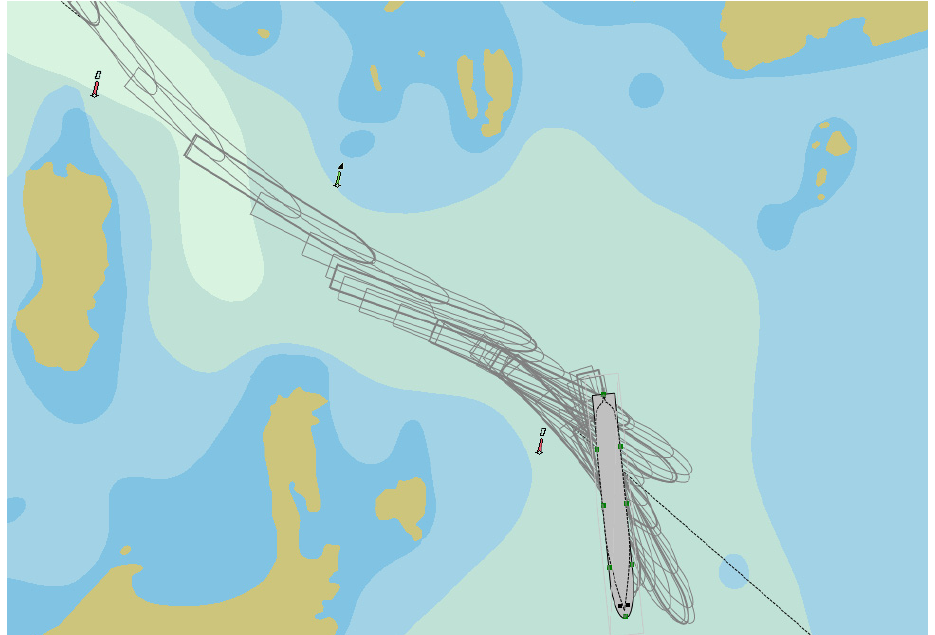
Figure 9. A PANAMAX-type container vessel crossing the navigational channel near Korsakobben Island (departure from Stockholm archipelago), where: buoys on chart are marked in black (own elaboration based on [73]).